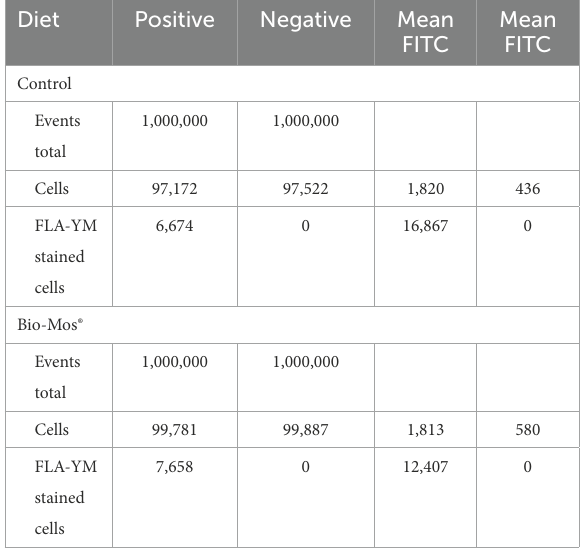
TABLE 1 Results of cell sorting of FLA-YM incubated control and Bio- Mos® enriched in vitro communities.